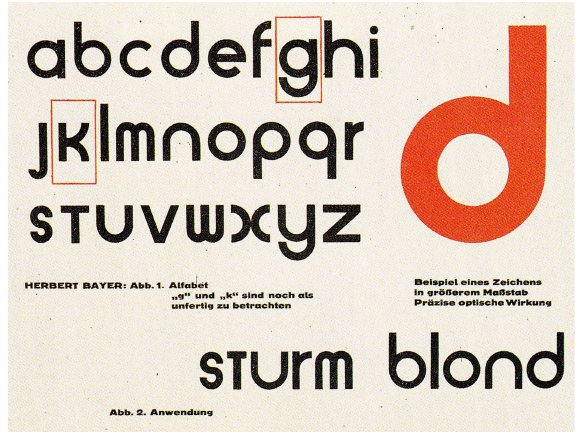
Figure 6. Herbert Bayer’s ‘Universal Type’